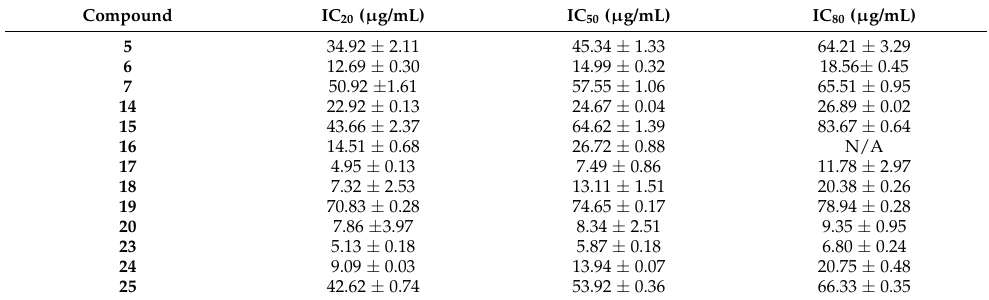
Table 1. Cytotoxic effects of tested compounds on RAW 264.7 monocyte/macrophage murine cells.